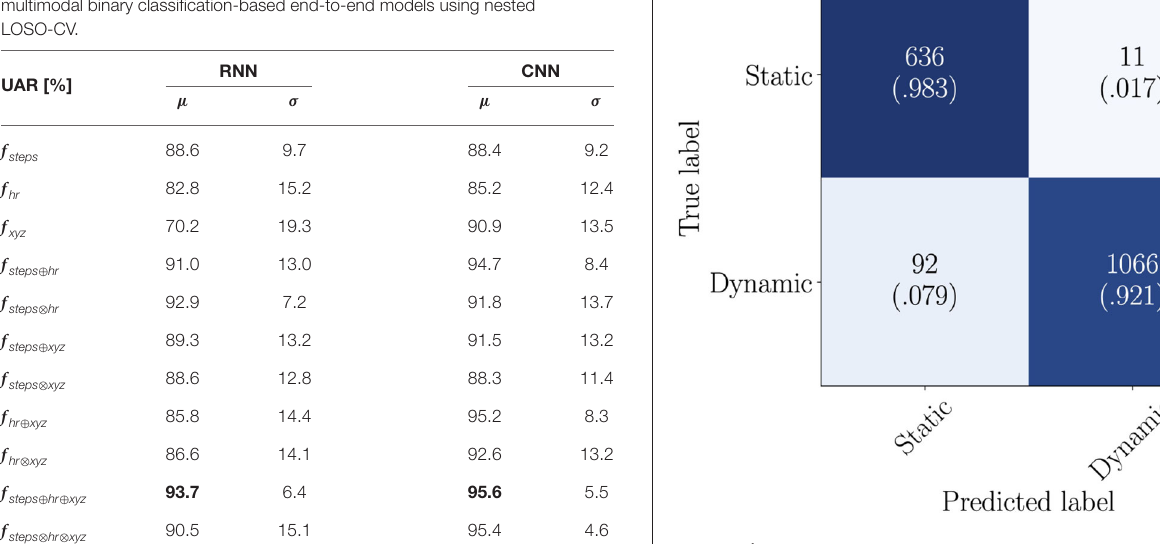
FIGURE 3 | Confusion matrix computed from the predictions inferred using the RNN-based approach exploiting f steps ⊕ hr ⊕ xyz as input features. The static class includes the lying, sitting, and standing activities, while the dynamic class includes the walking, running, stairs climbing, and cycling activities. Each cell contains the absolute and the relative number of samples of the actual class (row) classified into each possible activity of the recognition set (column). The relative information is also depicted using a color-scale: dark colors illustrate high percentages, while light colors, low percentages.